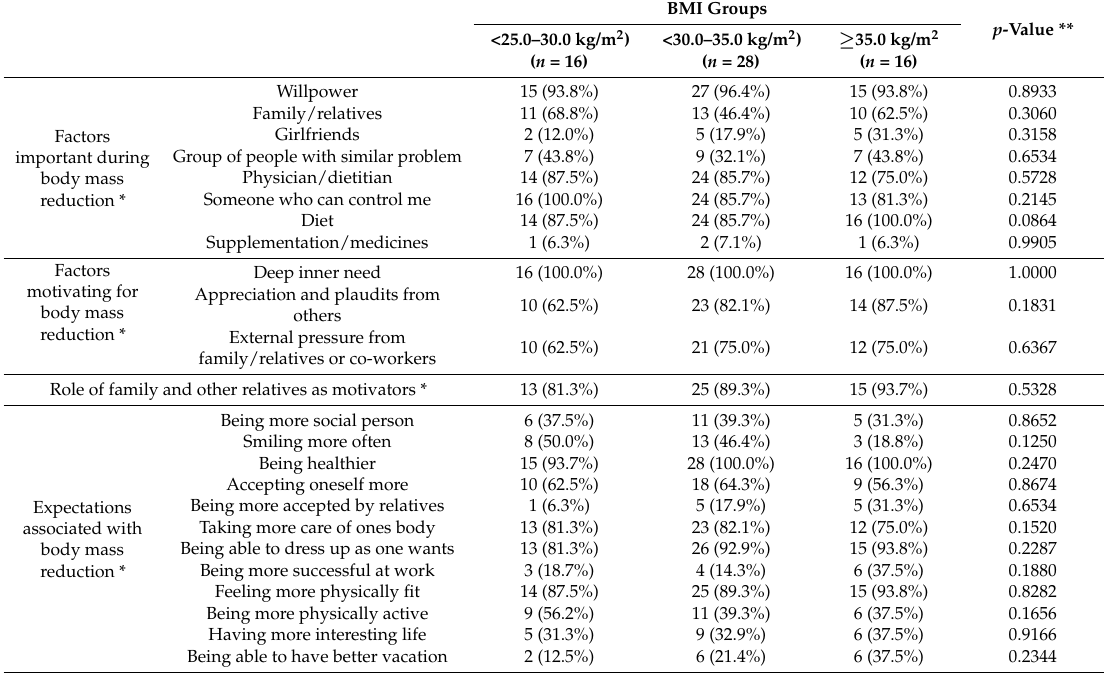
Table 8. The motivation towards body mass reduction in the studied group for the sub-groups stratified by